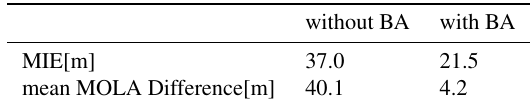
Table 3: Improvement of the EO of 3,686 HRSC data sets via bundle adjustment with a